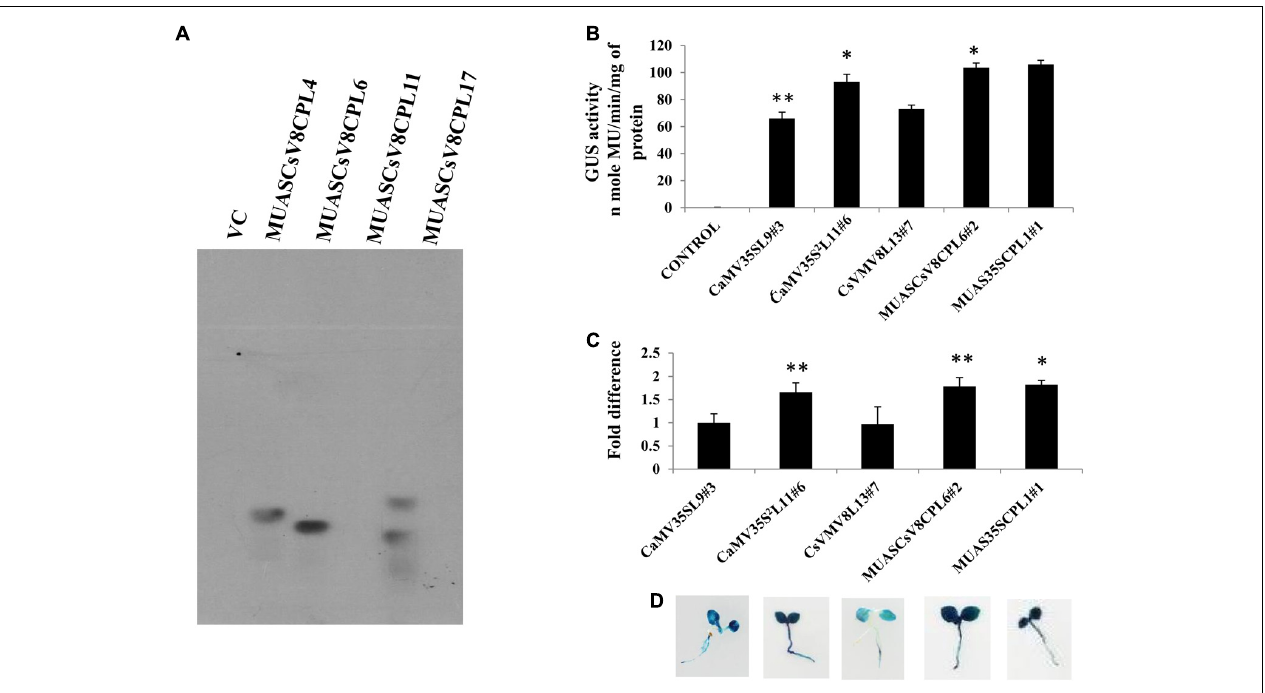
FIGURE 4 | Transgenic activity analyses of CsVMV8L13, MUASCsV8CPL6, MUAS35SCPL1, CaMV35SL9, and CaMV35S 2 L11. (A) Southern blot analyses performed to investigate uidA gene copy number in transgenic tobacco lines. (B) GUS expression analyses of the above promoter constructs in 21-day old transgenic seedlings. (C) Each bar represents the relative fold difference of uidA transcript levels of the respective constructs. The mean relative fold differences obtained from three independent experiments with respective SD for each promoter construct was presented. (D) Images of X -Gluc treated whole seedlings (T 2 generation) expressing GUS under the control of CsVMV8L13#7, MUASCsV8CPL6#2, MUAS35SCPL1#1, CaMV35SL9#3 and CaMV35S 2 L11#6 promoter constructs. Asterisks indicate level of significance where “ ∗∗ ” is more significant than “ ∗